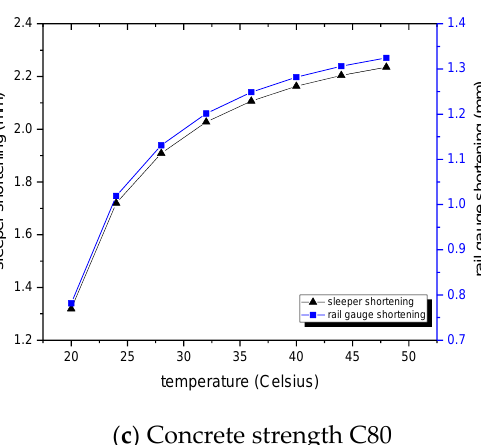
Figure 13. Total shortenings of prestressed concrete sleeper and rail gauge.